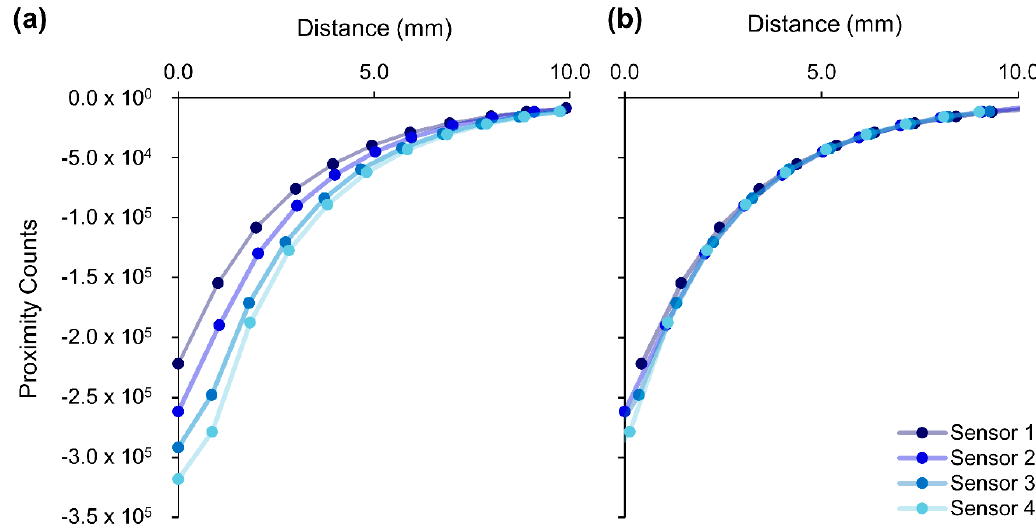
Figure A3. Sensitivity of sensors with varying radius of curvature: ( a ) unadjusted sensor output; ( b ) shifted sensitivity curves aligned well when an x-axis offset was applied.